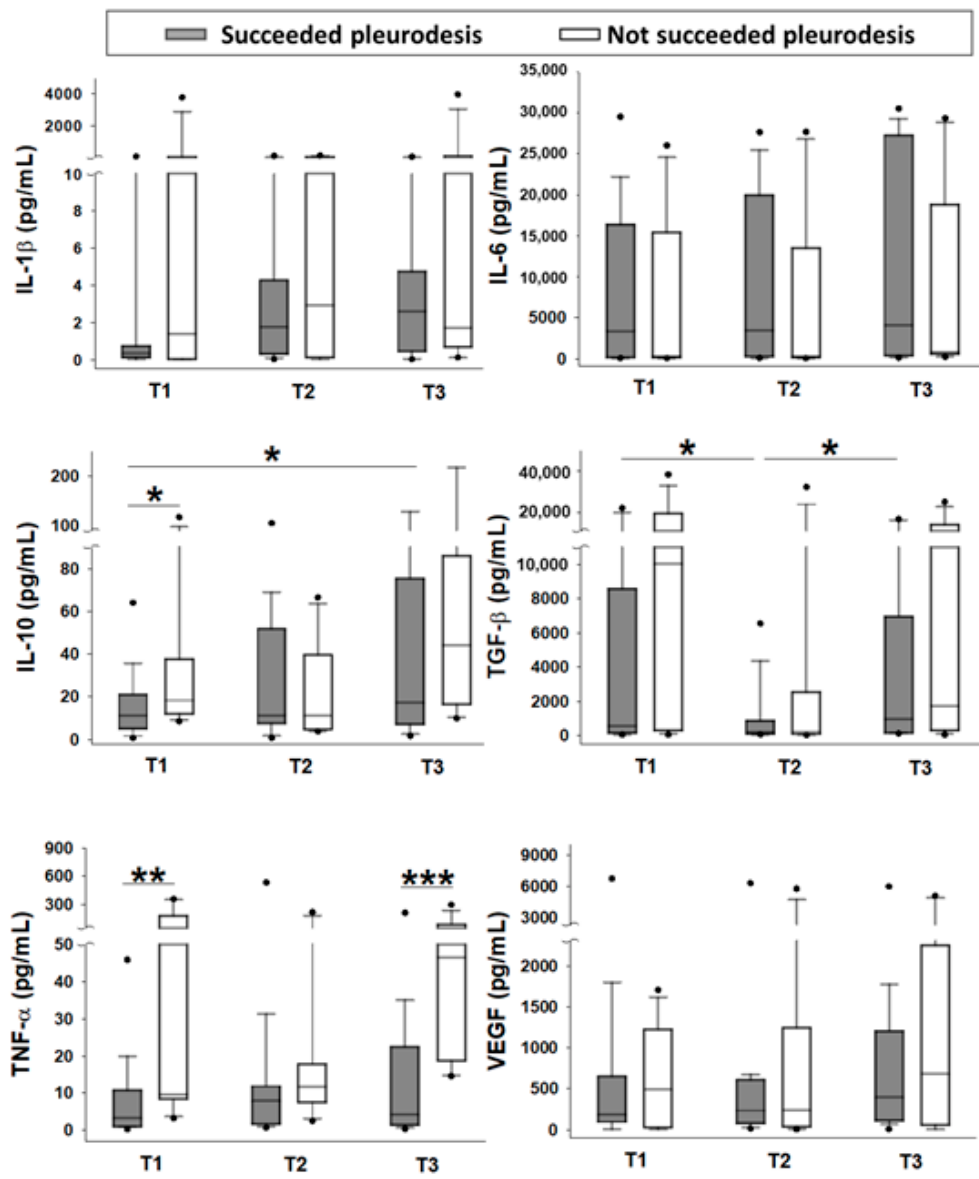
Figure 2. Measured cytokines in the pleural fluid at di ff erent time points. Interleukin (IL)-1 β , IL-6, IL-10, transforming growth factor beta (TGF- β ), tumor necrosis factor alpha (TNF- α ), and vascular endothelial growth factor (VEGF) levels were compared between patients who succeeded pleurodesis (grey column; n = 19) and those not succeeded (white column; n = 12). Comparison was also made at di ff erent time points within each group. Box plots demonstrate the concentrations in the pleural fluid. The dots represent the 5th and 95th percentiles, respectively. The error bars cover the 10th to 90th percentiles and the box covers 25th to 75th percentiles. The line within the box represents the median value. T1, before pleurodesis; T2, three hours after pleurodesis; T3, 24 h after pleurodesis; * p < 0.05; ** p < 0.01; *** p <